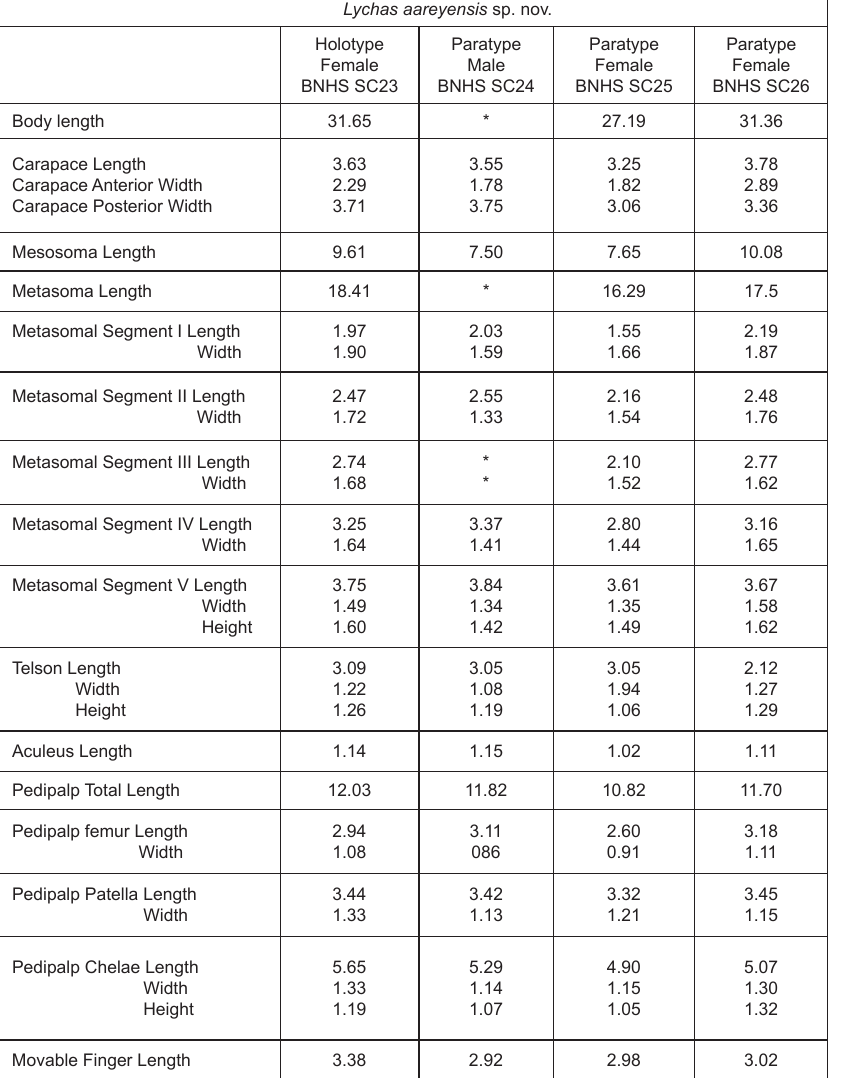
Table 1. Detailed measurements of the types of Lychas aareyensis sp. nov. (in mm.). Lychas aareyensis sp.